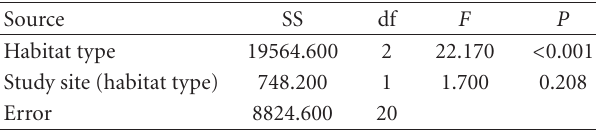
Figure 3: Abundance (mean number of individuals ± 1 SE) of ants in three habitat types at Mount St. Helens National Volcanic Monument sampled between 22 and 25 July 2008. Di ff erent letters above the bars indicate significant di ff erences ( P < 0 . 0001) between habitat types. Table 4: Overall nested ANOVA of the e ff ect of habitat type and study site on abundance of ants ( n =